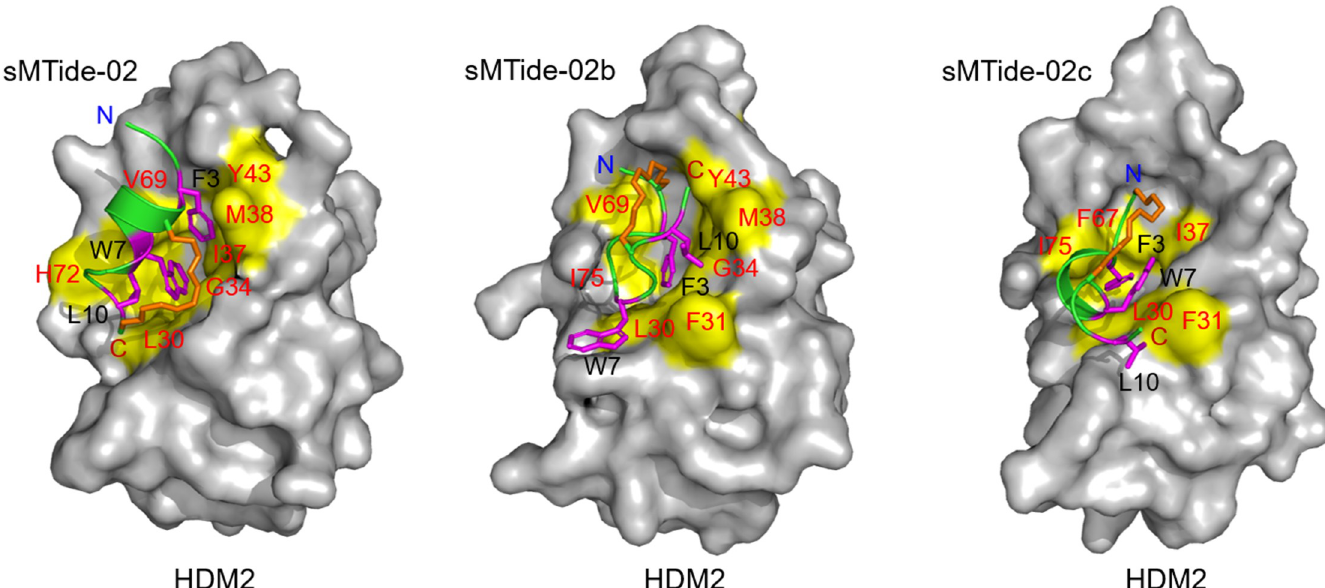
Fig 3. Representative structures of simulated stapled p53/HDM2 complexes. Three epitope residues (F3, W7, and L10; colored magenta) of the stapled p53 peptides are indicated by stick representations. The yellow surface shows the hydrophobic surface (comprising the residues colored red) of HDM2 interacting with the epitope